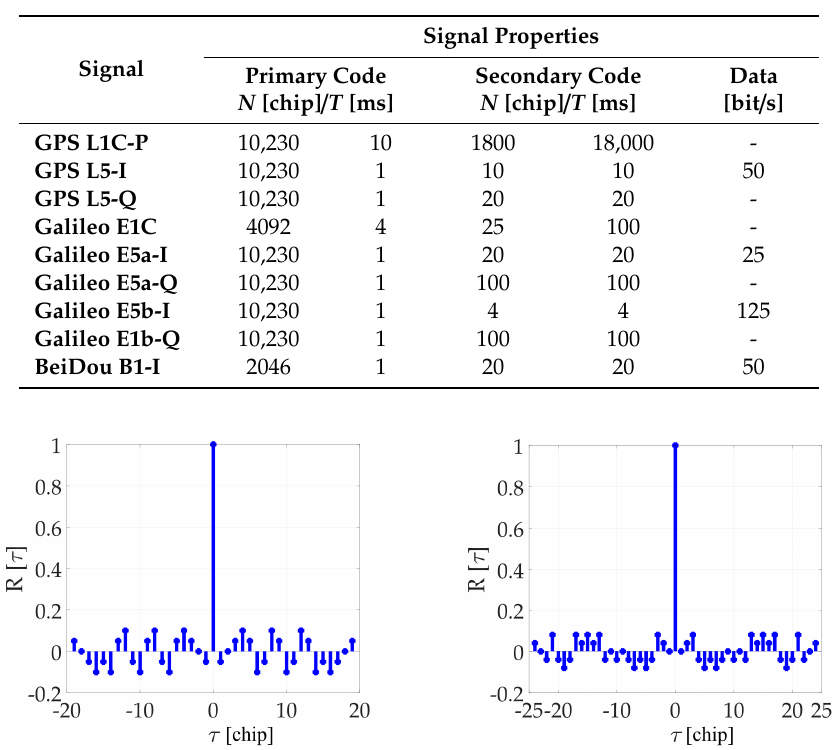
Table 1. Examples of Global Navigation Satellite Systems (GNSS) signals and secondary code (SC).